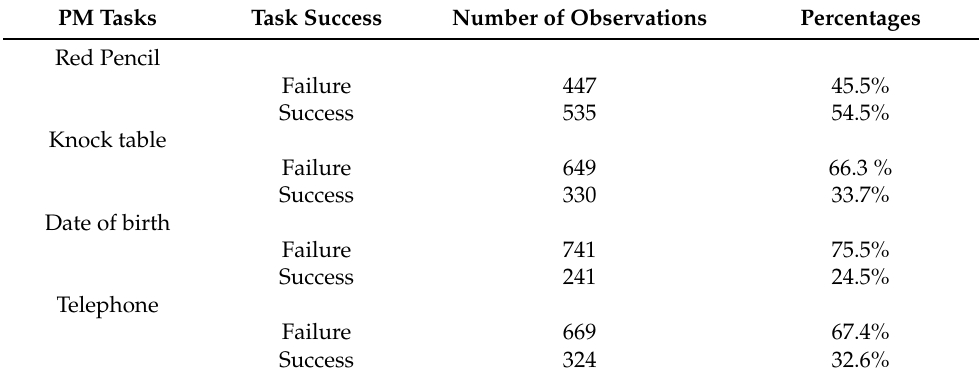
Figure 2. Standardized coefficients estimates for the structural equation model. Non-significant pathways are omitted. For clarity reasons, the missing-data-relevant variables and their significant correlations are not depicted. Table 1. Frequency table of the observed PM variables entered in the model.